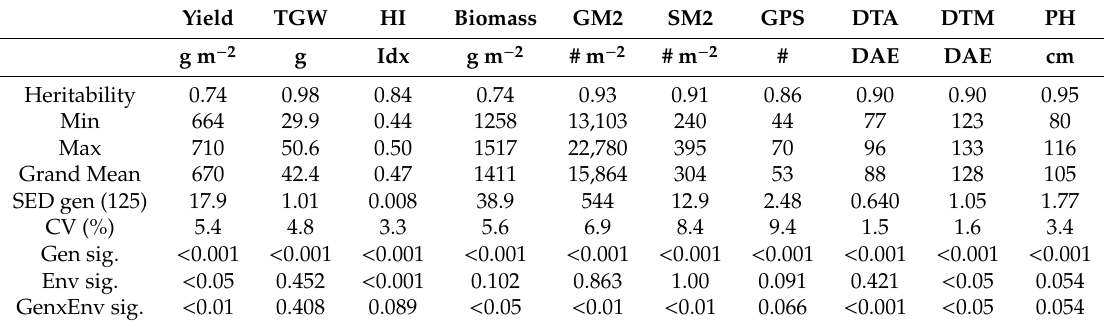
Table 1. Adjusted means and ranges for yield, yield components, plant height and phenology for the 26 cultivars of the International Maize and Wheat Improvement Center (CIMMYT)’s core germplasm (CIMCOG) from cross-year analysis of 2011, 2012 and